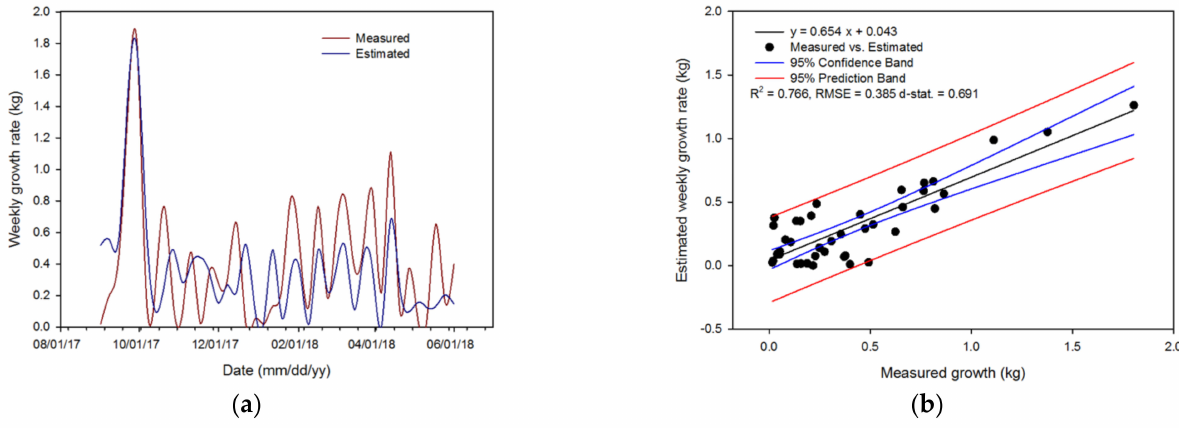
Figure 8. Environmental conditions in the greenhouse during validation periods from 1 August 2017 to 1 June 2018. Temperature, radiation, and CO 2 concentration ( a ), and relative humidity and substrate moisture content ( b ).